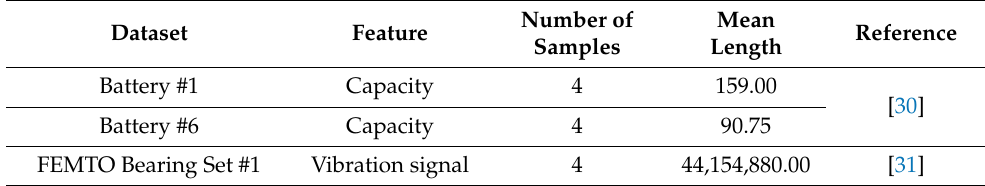
Table 4. Used datasets.